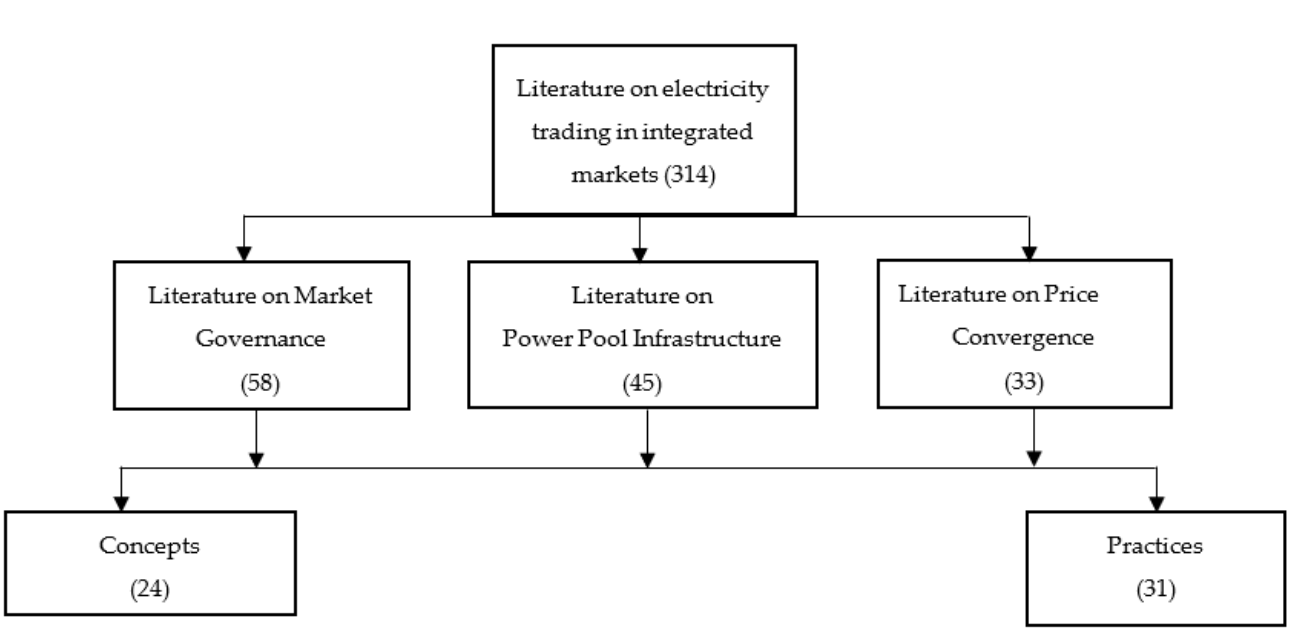
Figure 3 . Review strategy on concepts and practices used in integrated electricity markets .